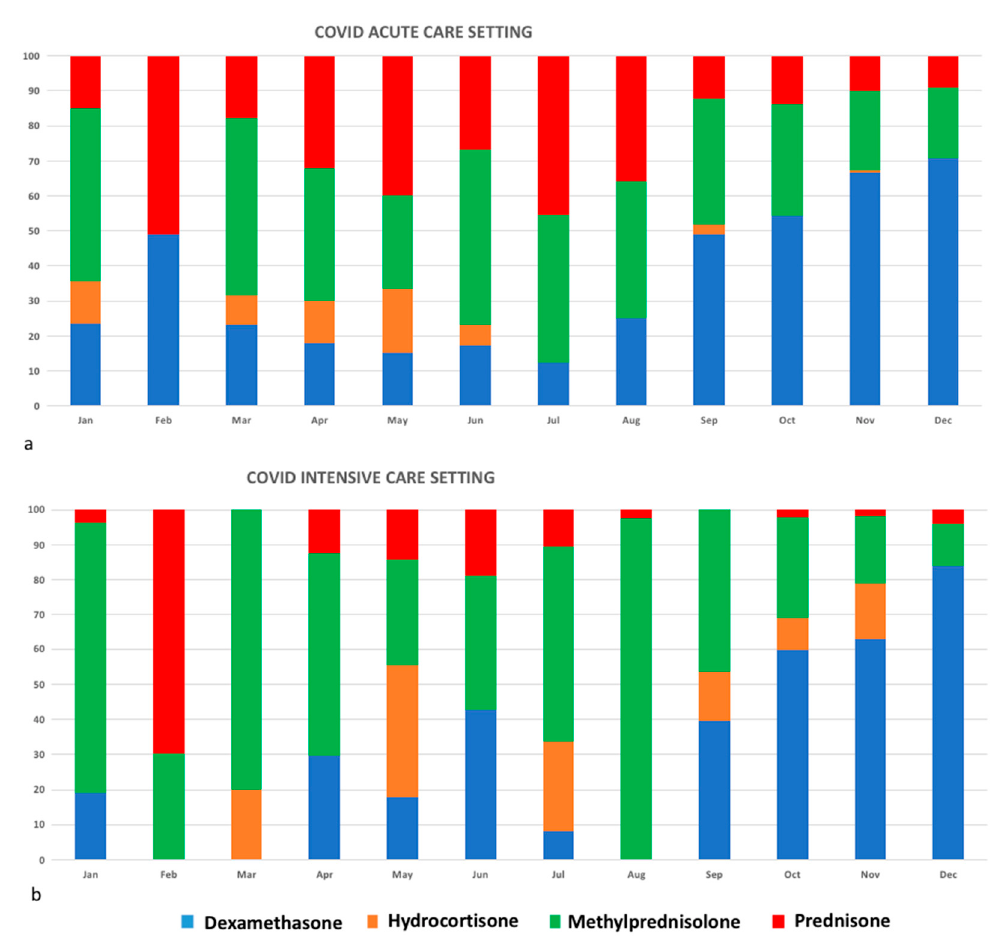
Figure 2. Different types of corticosteroids used in ACS ( a ) and ICS ( b ) from January to December 2020.